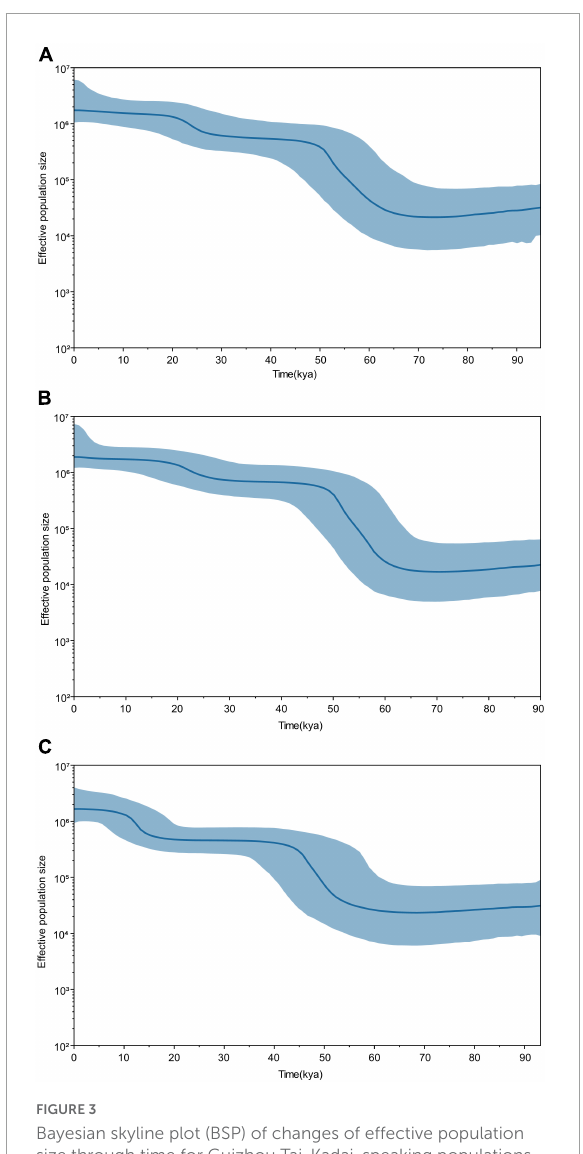
FIGURE3 Bayesian skyline plot (BSP) of changes of effective population size through time for Guizhou Tai-Kadai-speaking populations. The dark blue line represents the median population, the blue line demarcates the boundaries of the 95% highest posterior density. (A) BSP of the Guizhou Bouyei; (B) BSP of the Guizhou Dong; and (C) BSP of the Guizhou